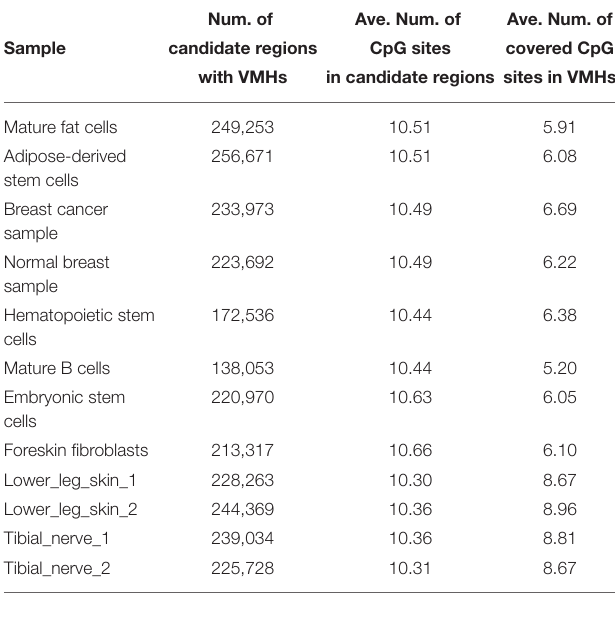
TABLE 2 | Statistics of candidate regions with methylation haplotypes in different samples. Num.